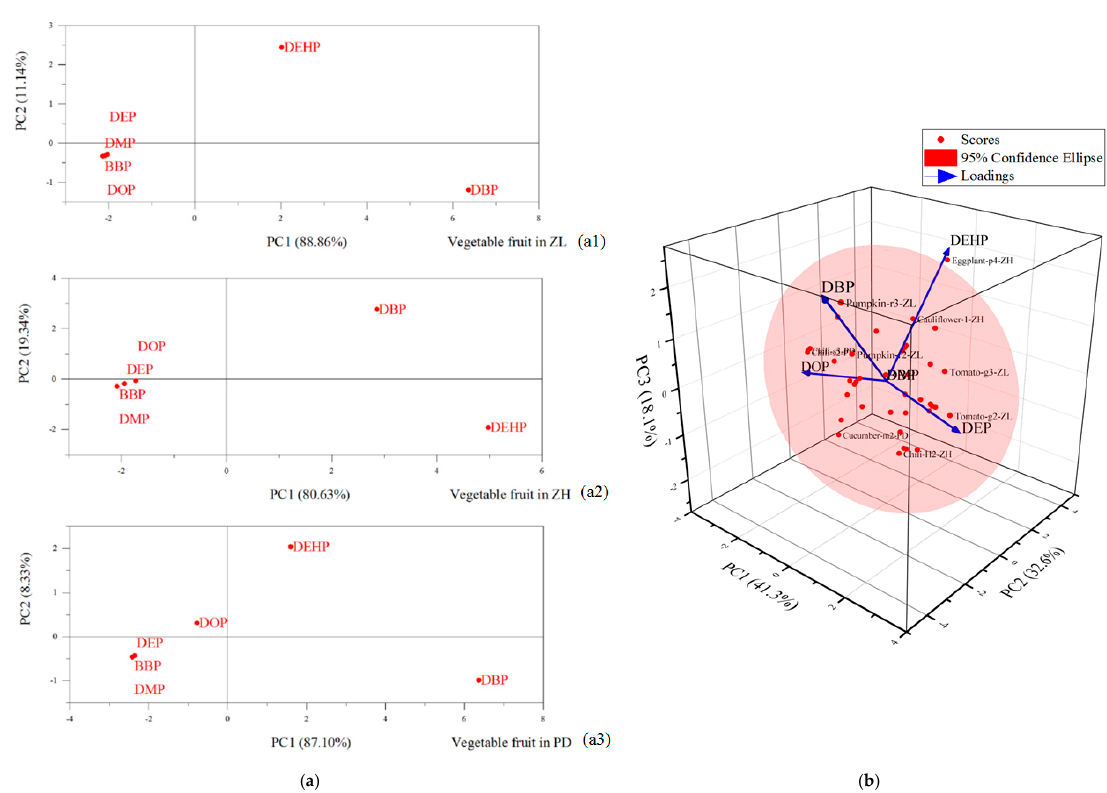
Figure 3. Principal component analysis (PCA) of PAEs in edible parts of samples collected from three study areas. ( a ) 2D PCA results of the six target pollutants in three individual study areas; ( a1 ) 2D PCA results of the six target pollutants at Zilingpu; ( a2 ) 2D PCA results of the six target pollutants at Zhanghe; ( a3 ) 2D PCA results of the six target pollutants at Pengdun; and ( b ) 3D PCA results of all vegetables determined. Pumpkin-r2-ZL, the second sampling greenhouse planted pumpkin (red chestnut) / red chestnut pumpkin in Zilingpu; Pumpkin-r3-ZL, the third sampling greenhouse planted pumpkin (red chestnut) / red chestnut pumpkin in Zilingpu; Tomato-g2-ZL, the second sampling greenhouse planted tomato (green) / green tomato in Zilingpu; Tomato-g3-ZL, the third sampling greenhouse planted tomato (green) / green tomato in Zilingpu; Eggplant-p4-ZH, the forth sampling greenhouse planted eggplant (purple long) / purple long eggplant in Zhanghe; Chili-H2-ZH, the second sampling greenhouse planted chili (Hangzhou) / Hangzhou chili in Zhanghe; Cauliflower-1-ZH, the first sampling greenhouse planted cauliflower in Zhanghe; Chili-s2-PD, the second sampling greenhouse planted chili (screw) / screw chili in Pengdun; Chili-s3-PD, the third sampling greenhouse planted chili (screw) / screw chili in Pengdun; Cucumber-m2-PD, the second sampling greenhouse planted cucumber (mini) / mini-cucumber in